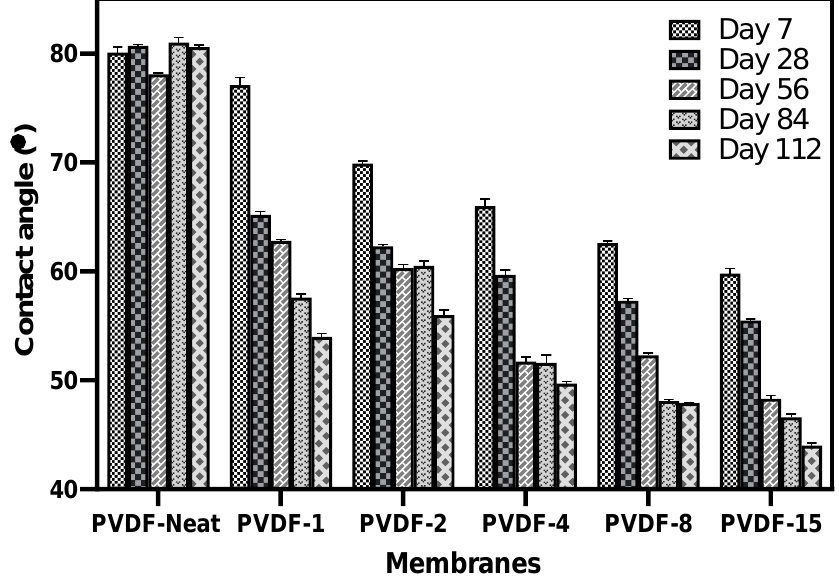
Figure 7. Contact angles of neat and embedded membranes at different acid concentrations.